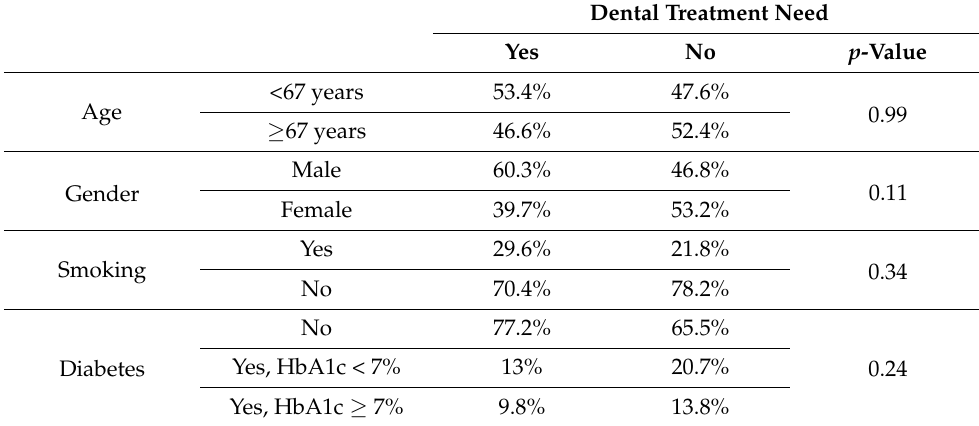
Table 7. Associations between demographic data and dental treatment need.